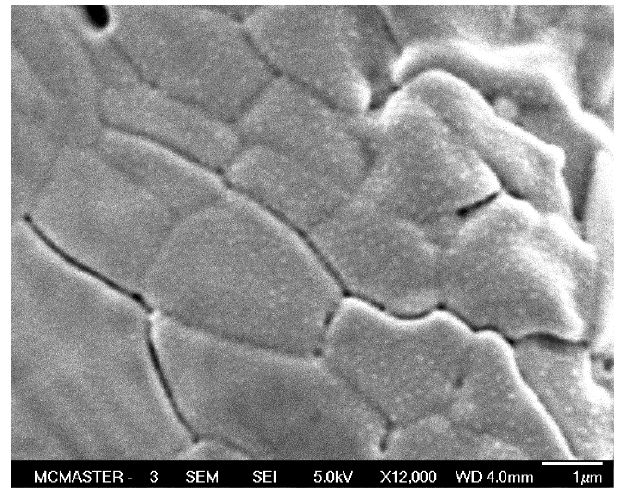
Figure 4. Planar SEM image of PyPbI 3 .